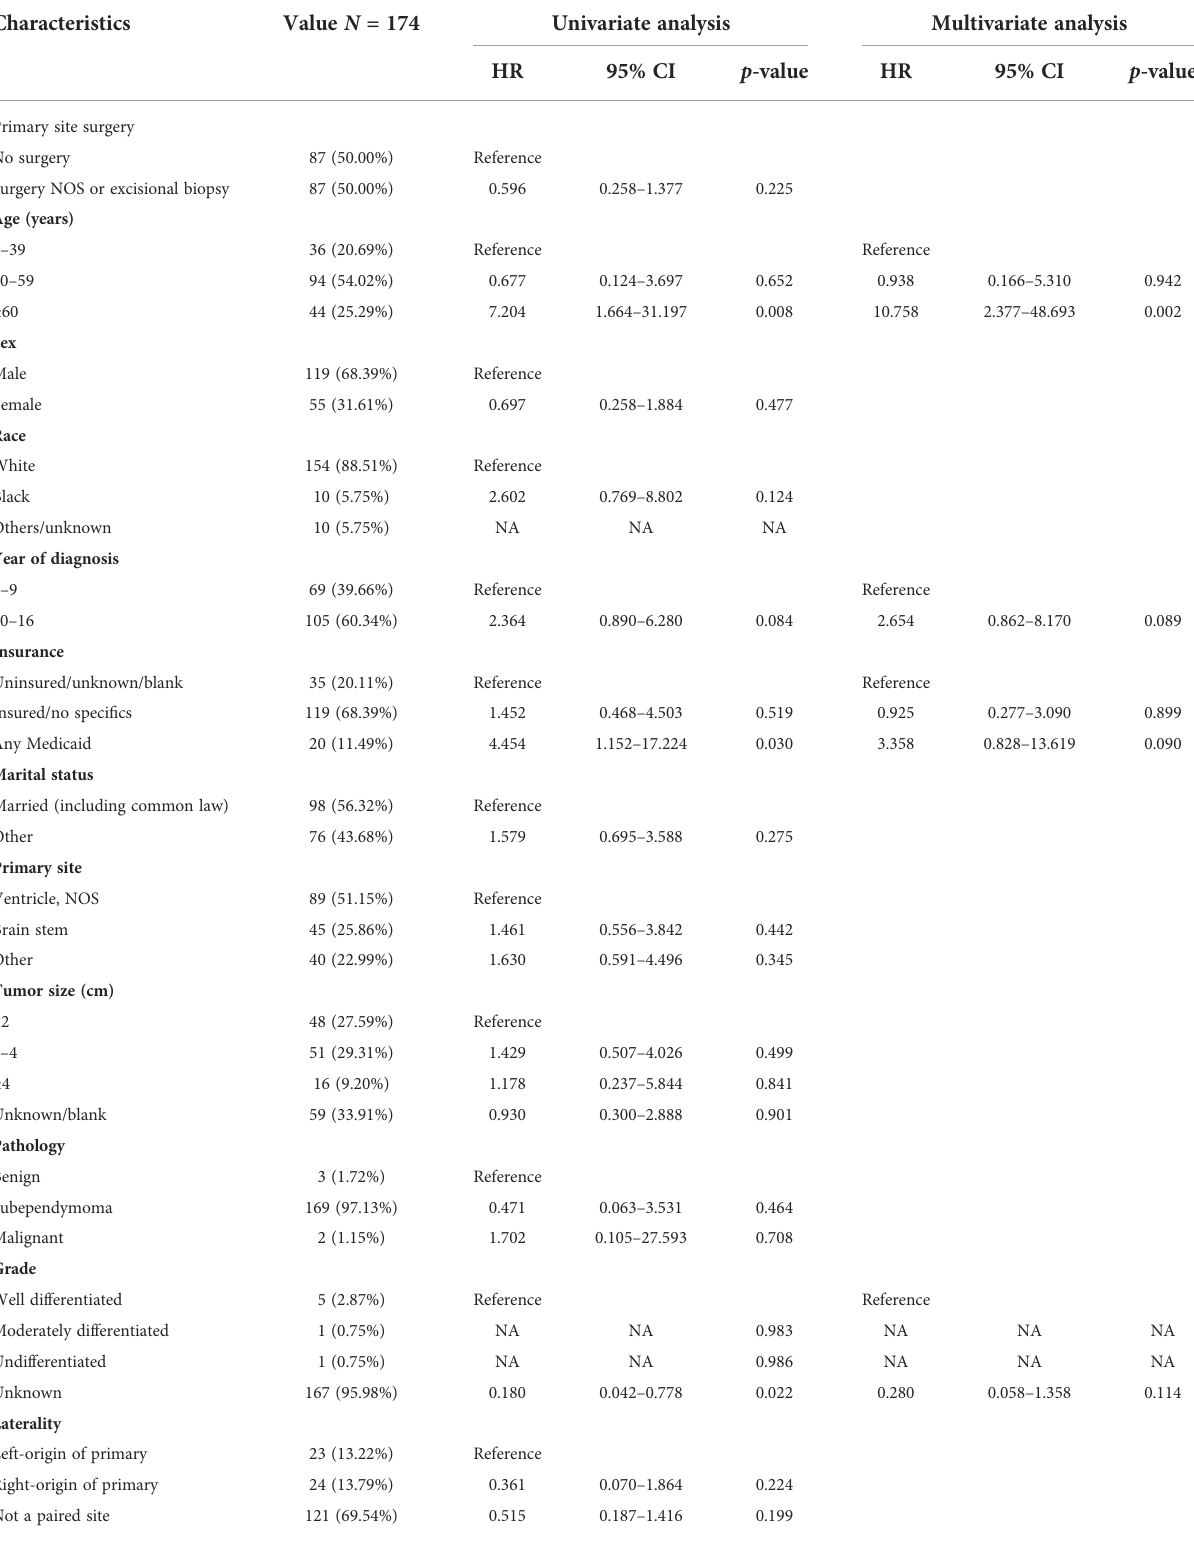
TABLE 6 The characteristics of 174 patients from the 344 patients grouped according to no surgery and surgery NOS or excisional biopsy after